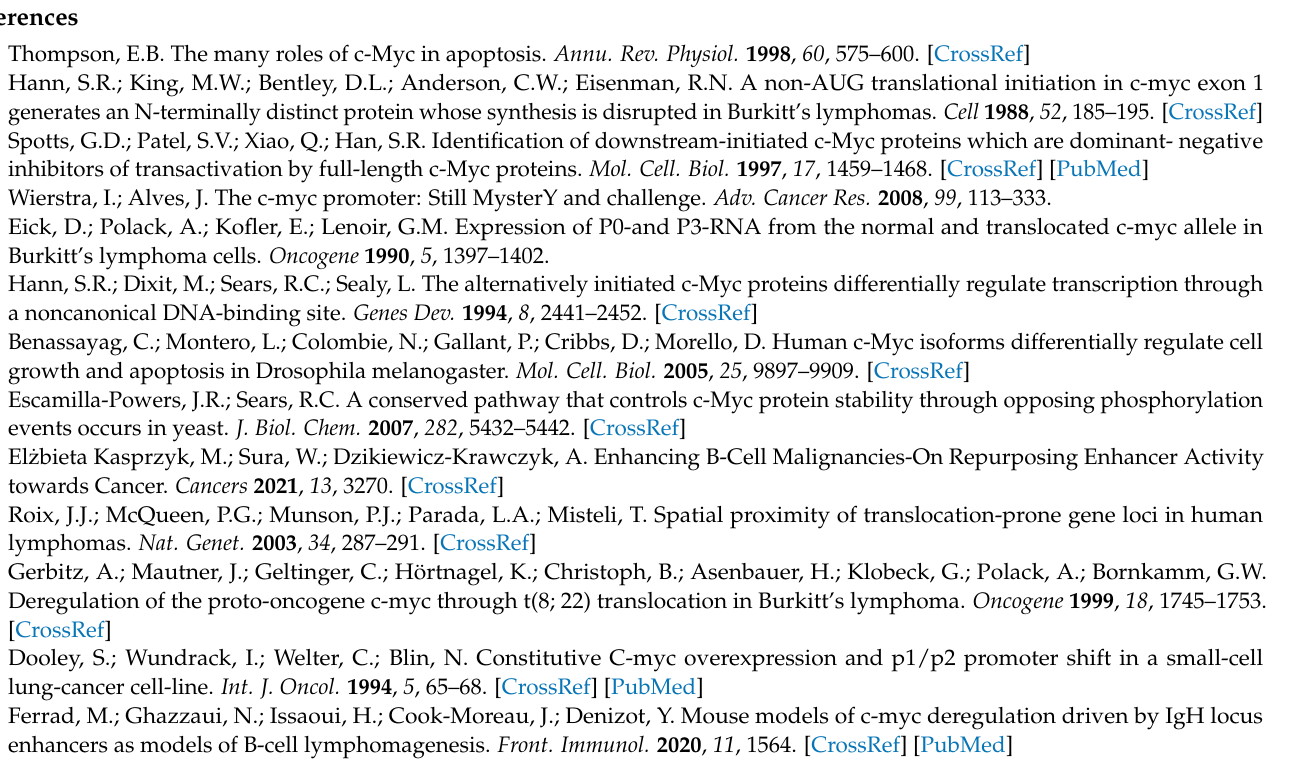
Figure S5: Nucleotide sequences of Trans3, Trans4, and Trans5 transcripts compared to the corre- sponding genomic structure. Underlined dinucleotides represent the splice sites found. The ATG initiation codons for c-Myc2 and c-MycS are indicated. Trans3 translation predicts c-Myc2 protein. Curiously and despite different splicings, Trans4 and Trans5 transcripts do not have a stop codon in their 5 (cid:48) UTR region. Potential non-ATG initiation sites are underlined. P3:+1: transcription initiation site from the P3 promoter. PFull3: Primer; M: The first amino acid, methionine. The rest of c-MYC sequence until the translation stop codon (TAA) is not shown. Figure S6: Nucleotide sequences of the only transcript expressed from a yet to be determined promoter (P?). The transcript exhibits an IGH sequence. This transcript encodes c-Myc2. PFull4: Primer; M: Methionine. The rest of c-MYC sequence until the translation stop codon (TAA) is not